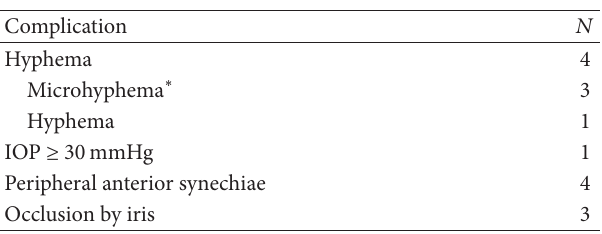
Table 1: Postoperative complications.